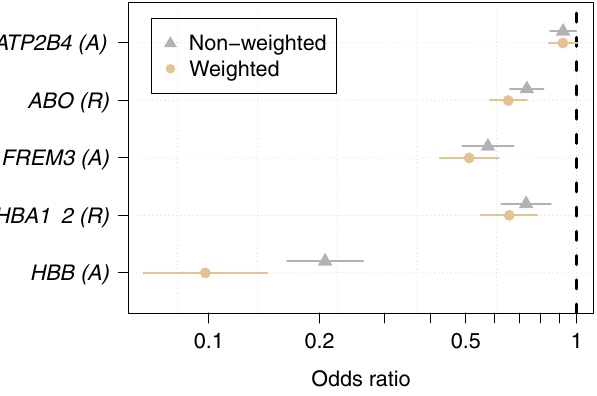
Fig. 4 Non-weighted versus probabilistically weighted case-control analysis. Odds-ratios (point estimates and 95% con fi dence intervals estimated under a logistic regression model) are shown for a case – control analysis for the fi ve major red cell